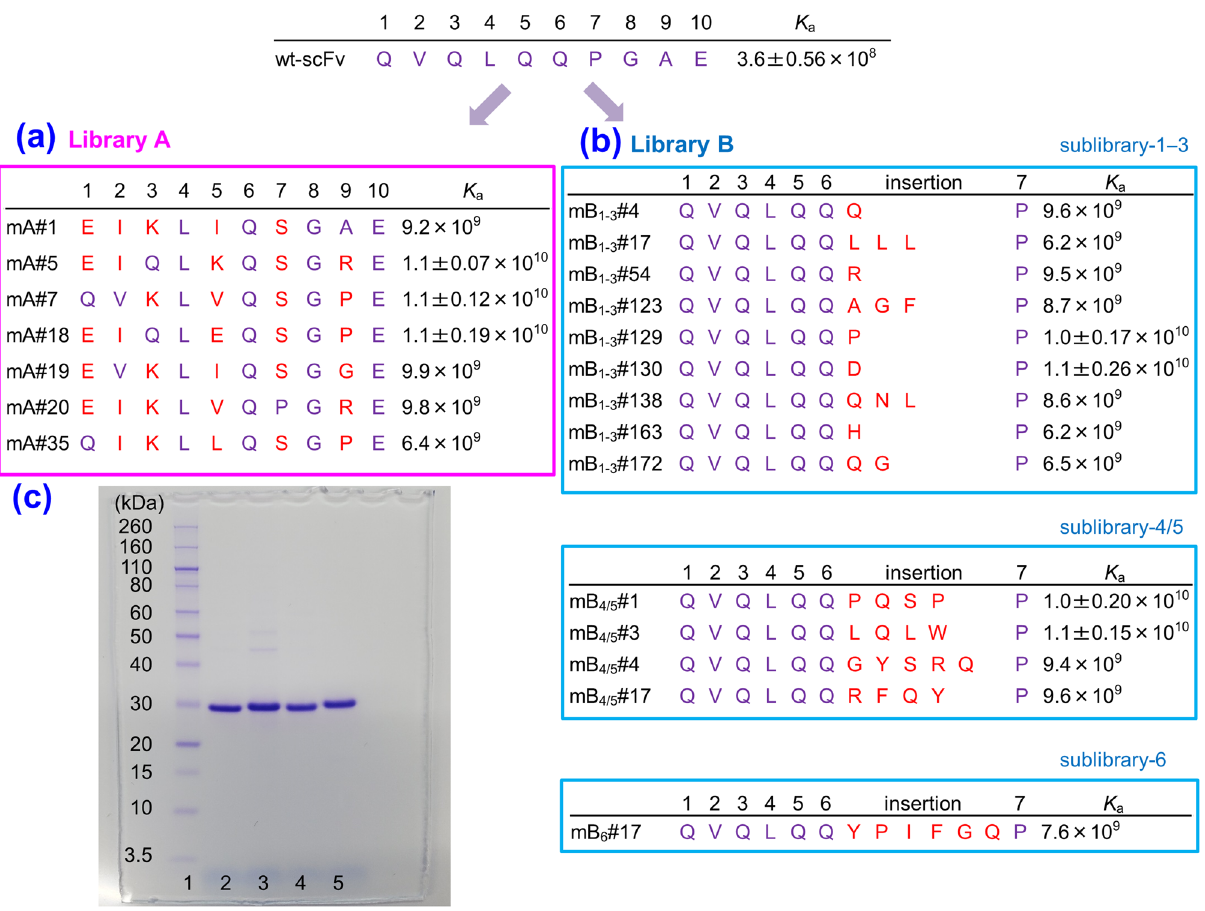
Figure 3. Structures and affinities of scFvs. ( a ) Amino acid sequences (the positions 1–10 of the V H ) of the improved scFvs obtained from the library A with the K a (M −1 ) values. ( b ) Amino acid insertions of the improved scFvs obtained from library B with the K a (M −1 ) values. No other substitution was found on the rest part of scFv sequences for all mutants. For comparison, the sequence and K a (M −1 ) value of wt-scFv were shown at the top of this figure. The K a values of wt-scFv and the mutants with > 10 10 M −1 were determined in triplicate, and mean ± SD was shown. The K a of wt-scFv was determined anew here for strict comparison, which differed slightly from the previous value (reported to be 3.8 × 10 8 M −1 ) 7,12 . Amino acid sequences were deduced from the nucleotide sequences and the numbering was based on the definition of Kabat et al. 18 . We have partly examined the slB-1–3 previously, and have found the scFv clones mB 1–3 #4, 17, 138, 163, and 172, which were reported as preliminary results (with the name of scFv#em1-4, -17, em2-138, -163, and -172, respectively) 7 . ( c ) SDS- PAGE analysis (Coomassie brilliant blue staining) of the selected mutant scFvs, which were affinity-purified with an anti-FLAG M2 agarose (Sigma–Aldrich) 8–13 : lane 1, M r marker; 2, scFv mA#5; 3, scFv mA#18; 4, scFv mB 1–3 #130; and 5, scFv mB 4/5